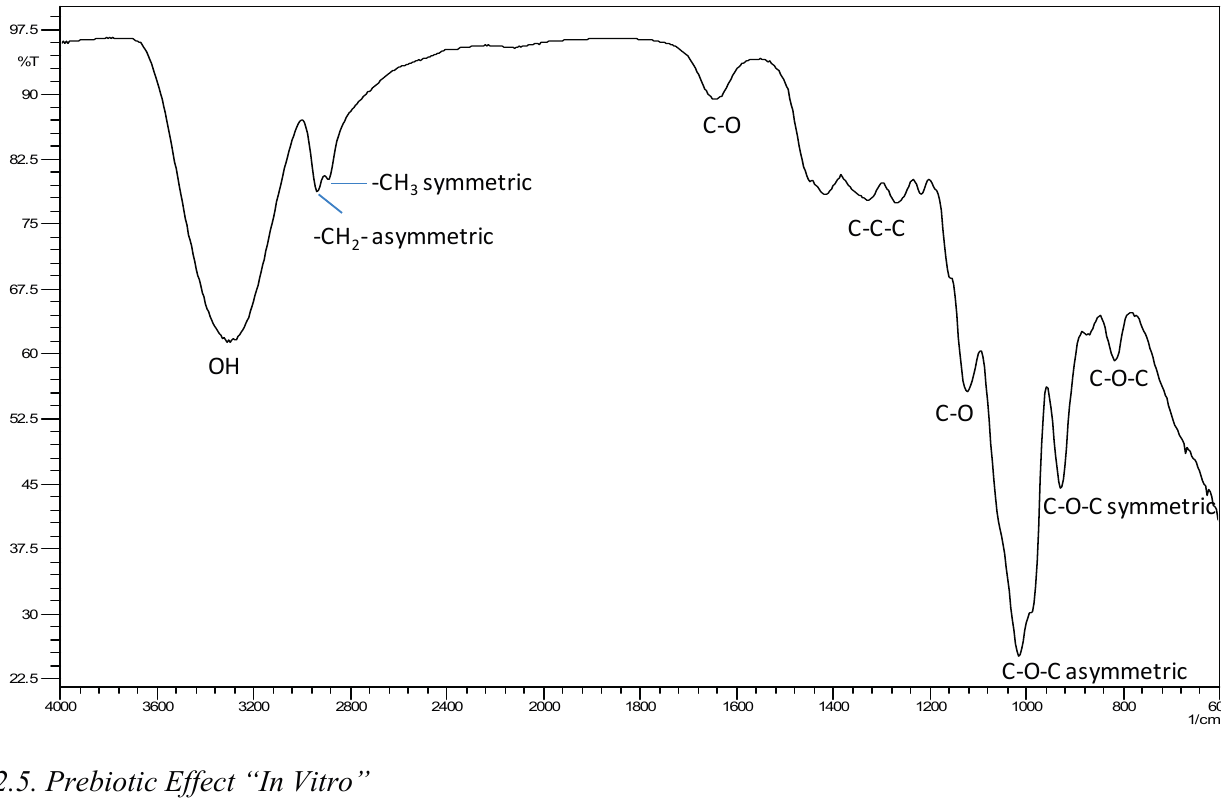
Figure 3. FTIR spectra of Agave fructan fraction (AFF1) from A. angustifolia